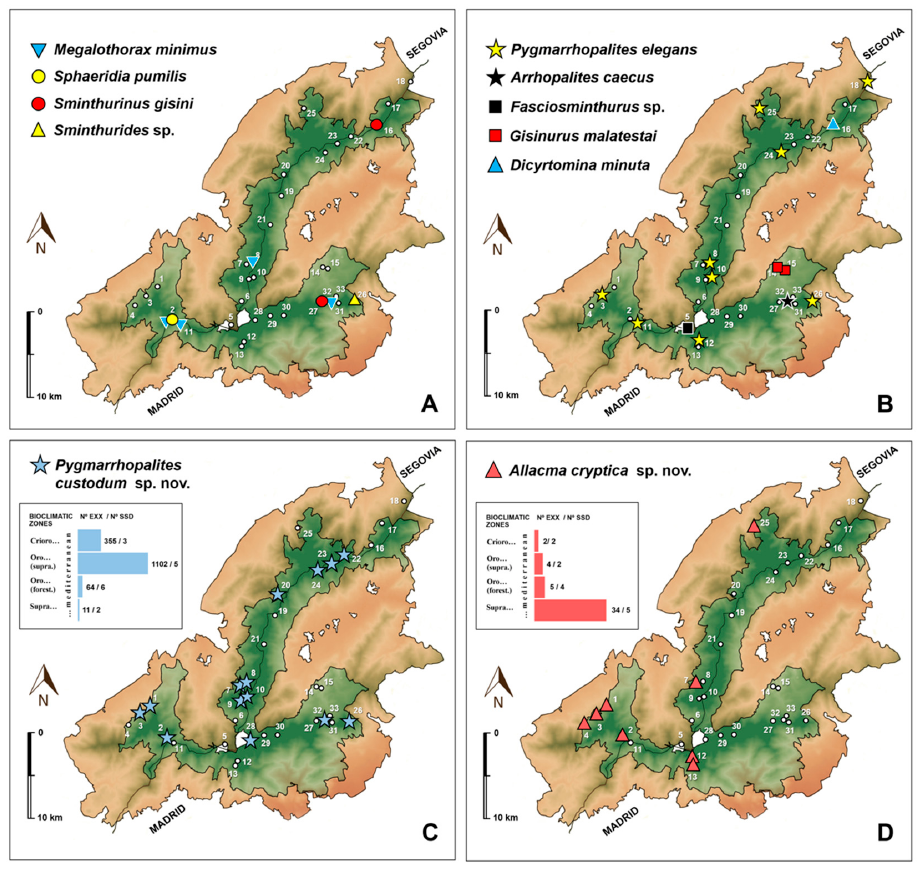
Figure 3. Distribution maps of Neelipleona and Symphypleona species collected in the mesovoid shallow substratum (MSS) of the Sierra de Guadarrama National